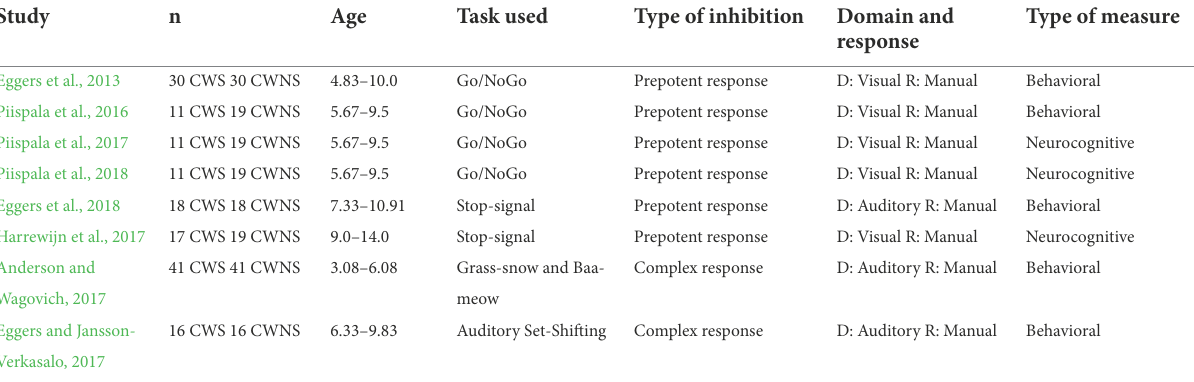
TABLE 1 Summary of studies that used behavioral and neurocognitive measures to assess inhibitory control in CWS and CWNS. Study